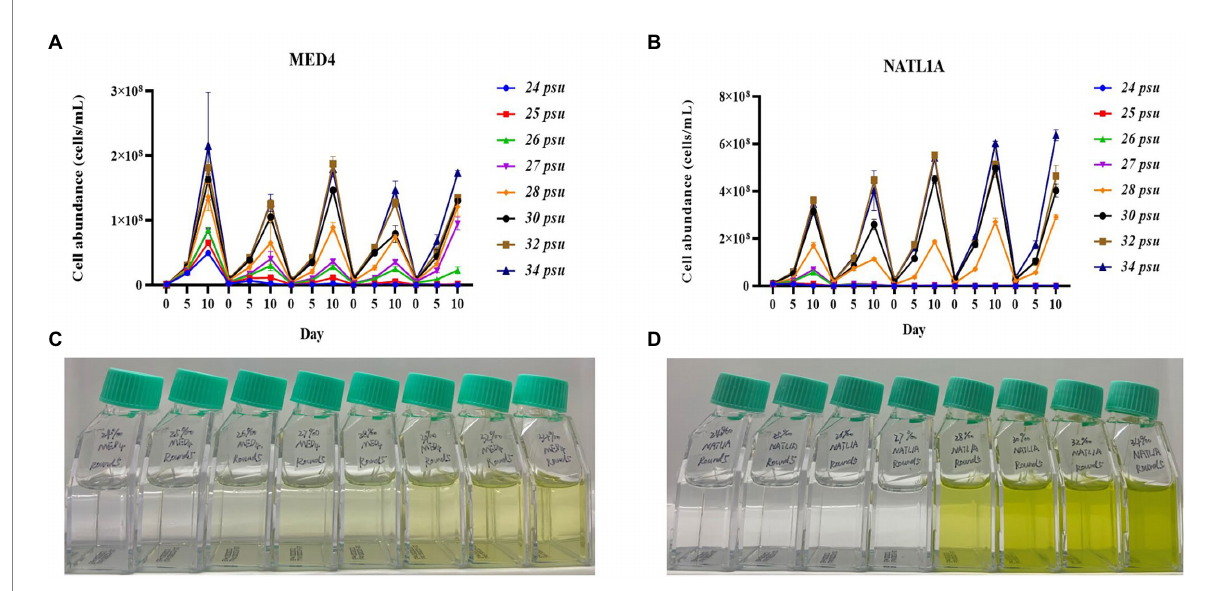
FIGURE 2 Acclimation of Prochlorococcus strains NATL1A and MED4 in different salinities. Five rounds of transfers were carried out and the growth (A,B) were monitored by flow cytometry. The pictures (C,D) showed the last round of cultures.